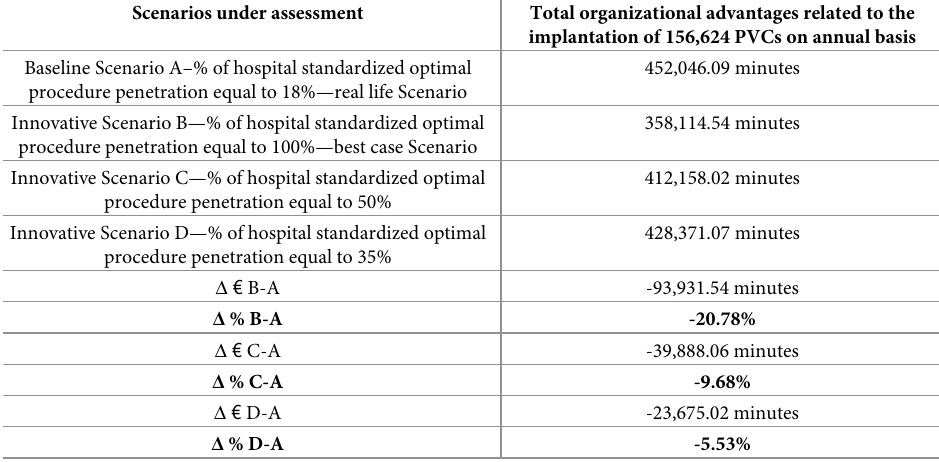
Table 8. Organizational